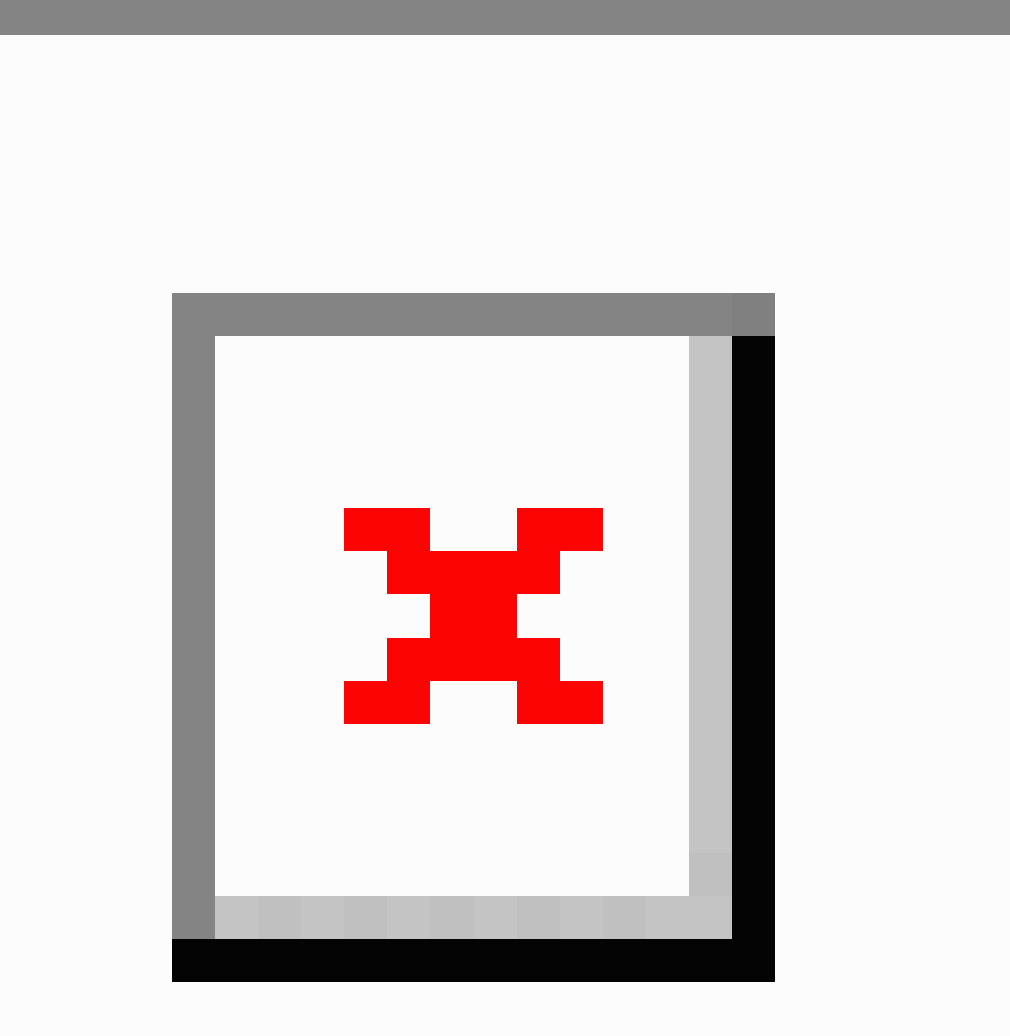
Figure 2. Conditional effects of youth age on the relationship between youth working alliance and change in child global functioning, as measured by the Children’s Global Assessment Scale (CGAS), from pretreatment to 6-month follow-up. Younger/older age represents -/+1 SD (2.5 years) below/above the mean (12.12